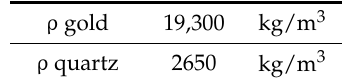
(cid:2) (cid:3) c E